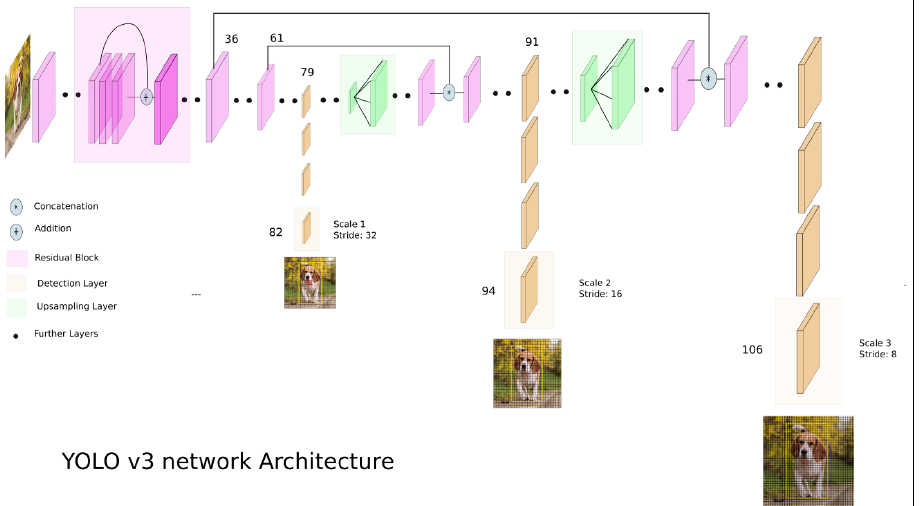
Figure 3. YOLOv3 Architecture. YOLO processes an overhead image of a football game and finds the locations of the visible players (image credit to Ayoosh Kathuria